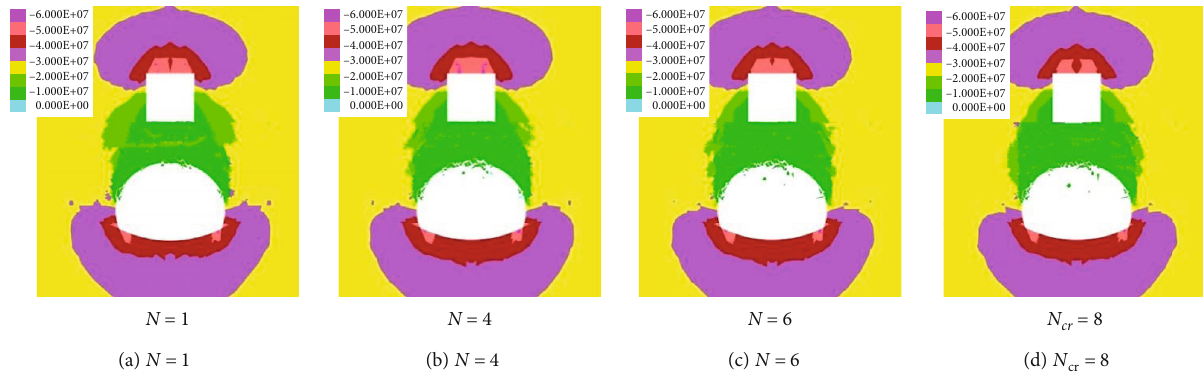
Figure 13: Evolution of maximum principal stress in the surrounding rock of the tunnel.